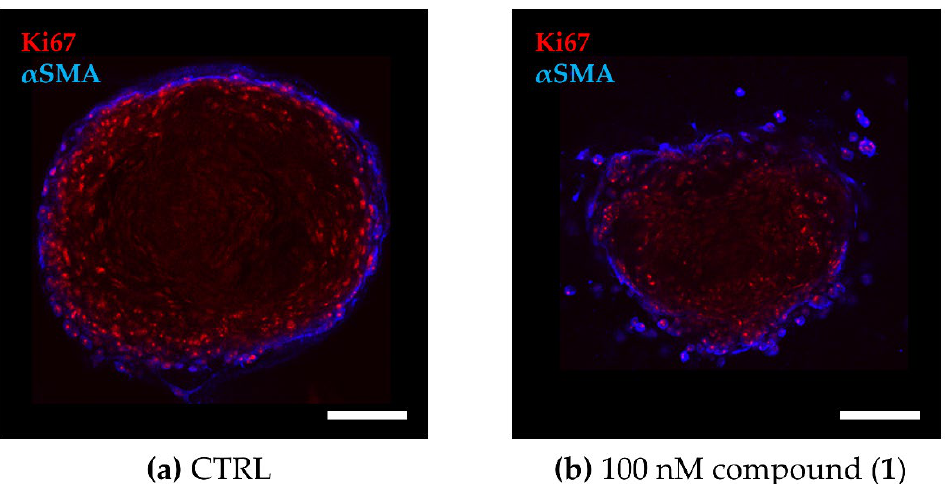
Figure 4. Cellular distribution within the TNBC co-culture spheroids. The 3D co-culture spheroids composed of primary murine CAFs and MDA-MB-231 cells were grown for 72 h before being treated for another 72 h. ( a , b ) Fluorescence images of co-culture spheroids that were ( a ) untreated (CTRL) or ( b ) treated with 100 nM of compound ( 1 ). Optical cross sections of the spheroids were captured after immune staining for Ki67 (red, MDA-MB-231) and α SMA (blue, CAF). Scale bar: 100 µm. The effect on cell viability of PAs was assessed in parallel in the 3D co-culture spheroids and in single cell type (MDA-MB-231 or CAF) 2D cultures (Table 1, Table 2 and Table S1). Table 2. IC 50 -values determined for the reduction of cell viability in the 3D co-culture spheroids. Compound ( 1 ) represents the most cytotoxic agent in the co-culture spheroids with an IC 50 of 21.7 ± 2.5 nM, with only a minor increase in comparison to the 2D IC 50 . In contrast, compounds ( 2 ), ( 3 ), and ( 4 ) exhibit reduced cytotoxicity in the 3D co-culture